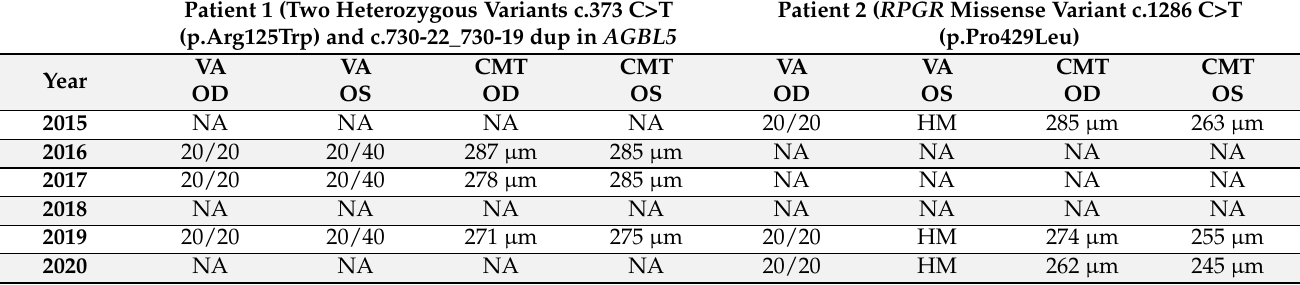
Table 2. Serial visual acuity and serial central macular thickness measurements by spectral domain optical coherence tomography (SD-OCT) in 2 patients with unilateral retinitis pigmentosa. Both patients had stable vision and central macular thickness throughout the